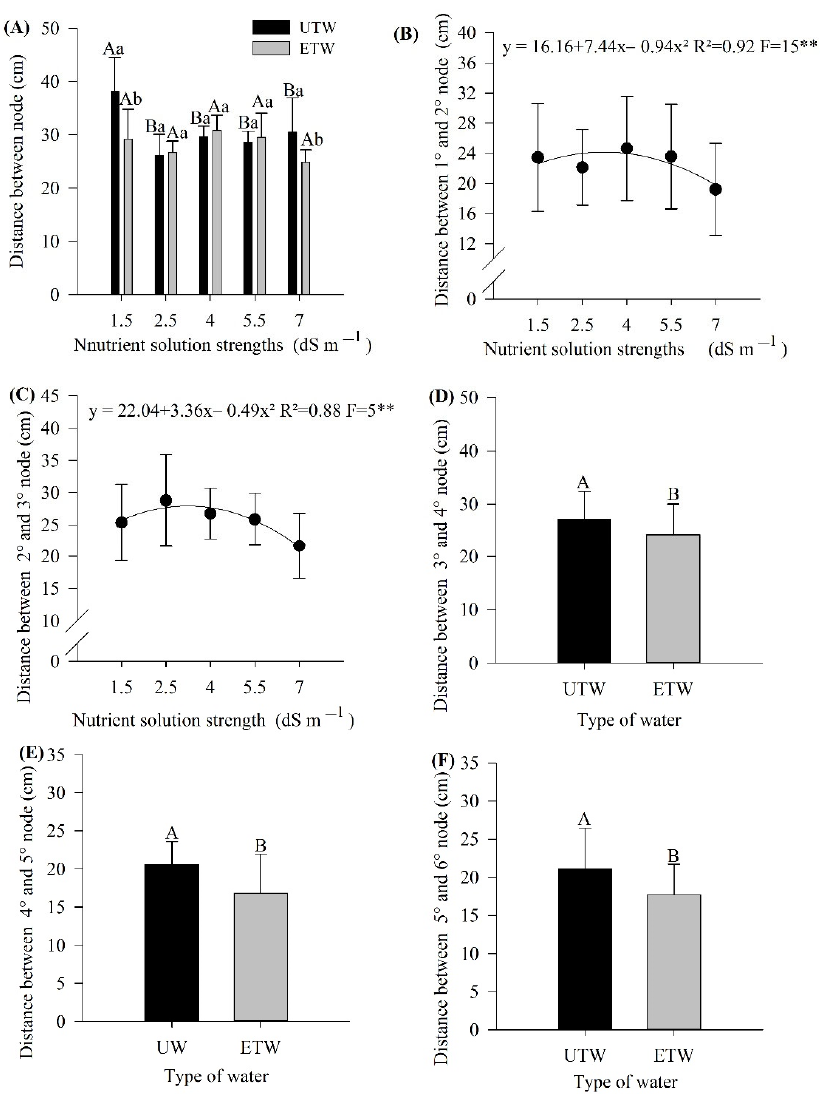
Figure 1. Distance between nodes in tomato culture submitted to different strength nutrient solution with electromagnetically treated water (ETW) and untreated water (UTW). ( A ) Distance between node (cm), ( B ) Distance between 1° and 2° node (cm), ( C ) Distance between 2° and 3° node (cm), ( D ) Distance between 3° and 4° node (cm), ( E ) Distance between 4° and 5° node (cm), ( F ) Distance between 5° and 6° node (cm) According to the Tukey test, the means followed by the same letter, lower case comparing the type of water and upper case comparing the strength of the nutrient solution, do not differ statistically ( p < 0.05). The error bars indicate the standard deviation of the average of four repetitions ( n = 4). ns: not significant, ** significant at 1%. Regarding the distances between the first and second internodes and the second and third internodes, there was only the effect on the strength of the nutrient solution (Figure 1B,C). The maximum point for the quadratic adjustment occurred close to the strength of the nutrient solution of 2.5 dS m − 1, followed by a significant reduction, for both distances (Figure 1 B, C). Lower internode distances were observed for plants that received ETW ( p < 0.05) (Figures 1 D,F,E respectively).